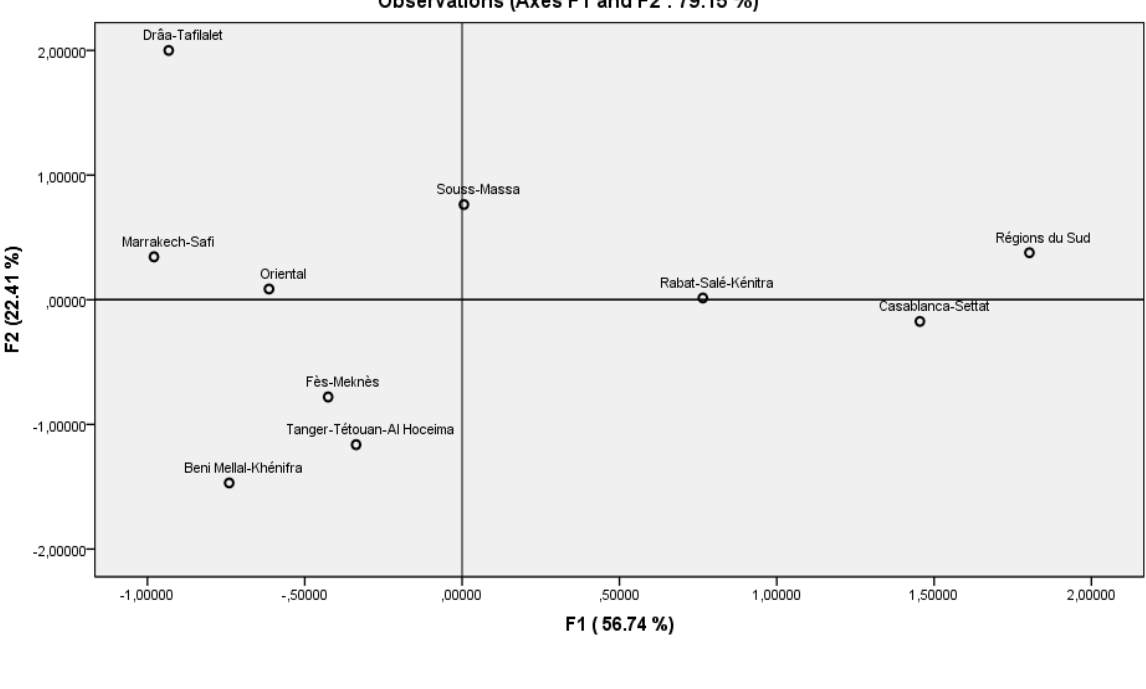
Projection of the regions on the factorial plane (F1,